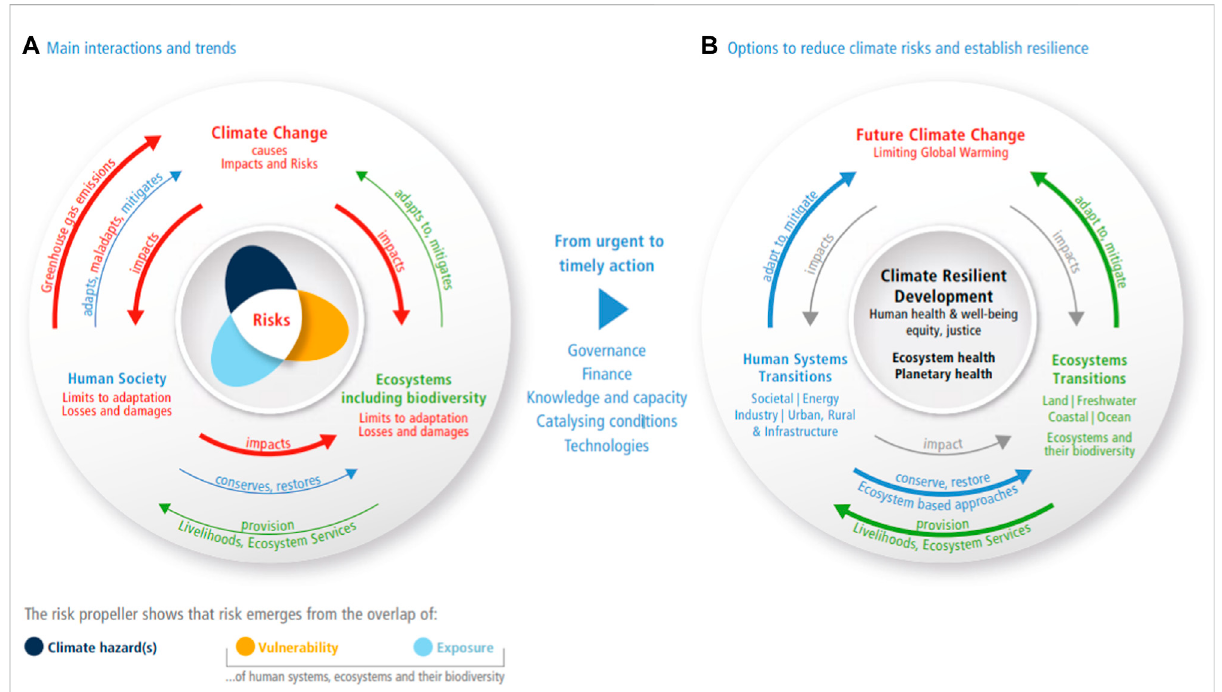
FIGURE 1 From climate risk to climate resilient development: climate, ecosystems (including biodiversity) and human society as coupled systems. Interactions among the coupled systems climate, ecosystems (including their biodiversity) and human society are the basis of emerging risks from climate change, ecosystem degradation and biodiversity loss and, at the same time, offer opportunities for the future. (A) Human society causes climate change. Climate change, through hazards, exposure and vulnerability generates impacts and risks that can surpass limits to adaptation and result in losses and damages. Human society can adapt to, maladapt and mitigate climate change, ecosystems can adapt and mitigate within limits. Ecosystems and their biodiversity provision livelihoods and ecosystem services. Human society impacts ecosystems and can restore and conserve them. (B) Meeting the objectives of climate resilient development thereby supporting human, ecosystem and planetary health, as well as human well-being, requires society and ecosystems to move over (transition) to a more resilient state. The recognition of climate risks can strengthen adaptation and mitigation actions and transitions that reduce risks. Taking action is enabled by governance, fi nance, knowledge and capacity building, technology and catalysing conditions. Transformation entails system transitions strengthening the resilience of ecosystems and society (Section E in IPCC, 2022). In (A) arrow colours represent principle human society interactions (blue), ecosystem (including biodiversity) interactions(green)andtheimpactsofclimatechangeandhumanactivities,includinglossesanddamages,undercontinuedclimatechange(red).In (B) arrow colours represent human system interactions (blue), ecosystem (including biodiversity) interactions (green) and reduced impacts from climate change and human activities (grey). Taken from: IPCC, 2022, Figure TS.2, page 42, and chapter 1.2, Figure